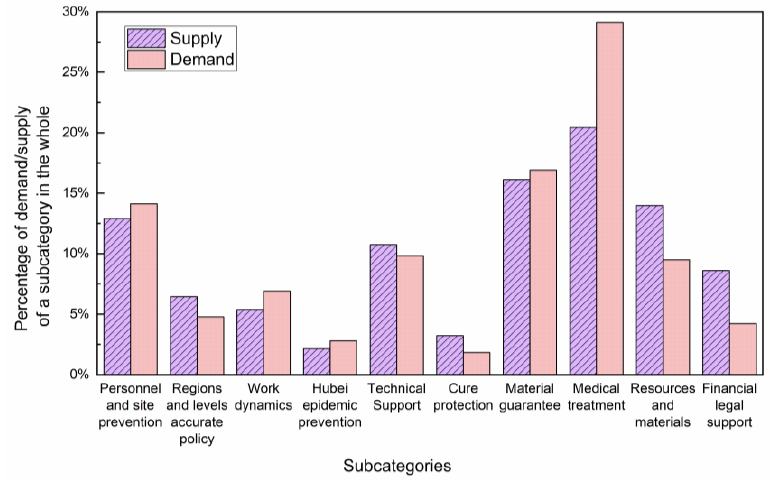
Figure 13. The supply and demand of subcategories of government policies and measures in the control stage.